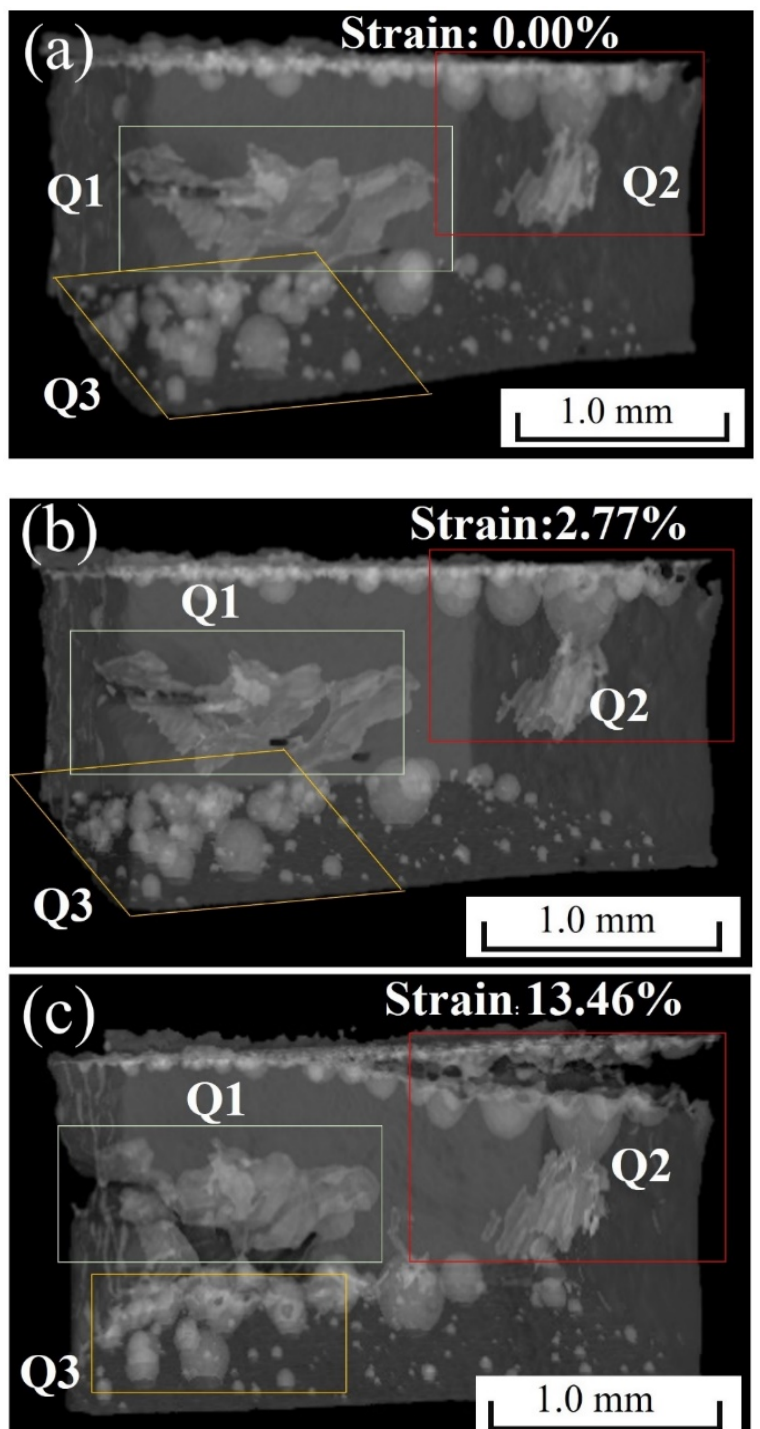
Figure 7. Three-dimensional internal defects in microstructure of solder joints at the strain of: ( a ) 0.00; ( b ) 2.77%; ( c ) 13.46%.